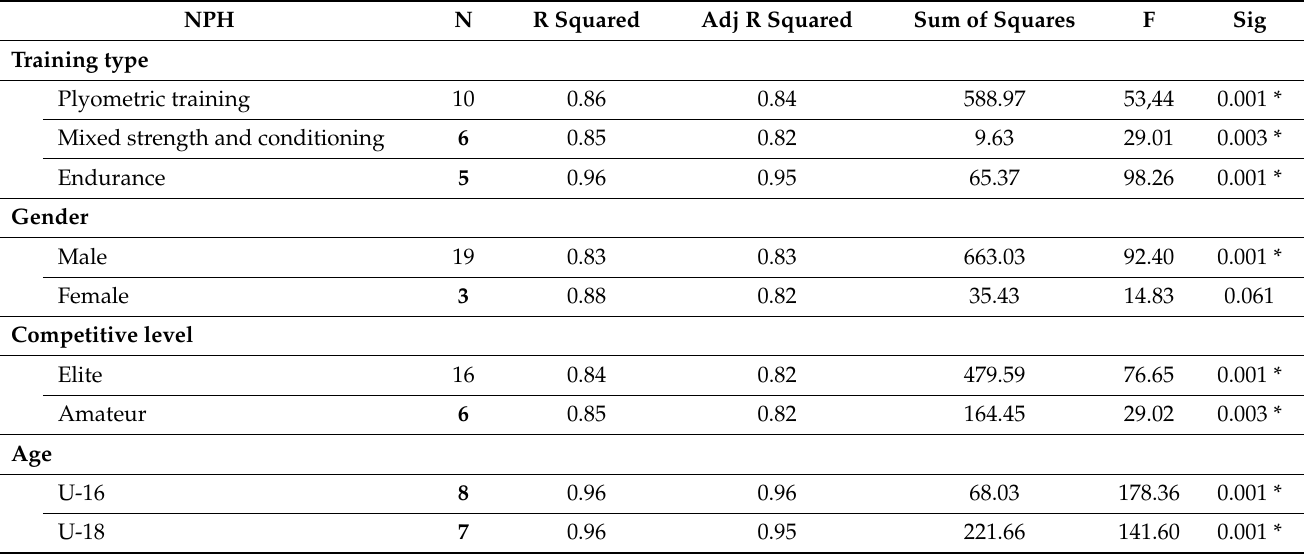
Table 5. Meta-regression statistical analysis for neuromuscular power horizontal (NPH) according to sub groups. In bold, models that did not reach the minimum 10 studies for meta-regression